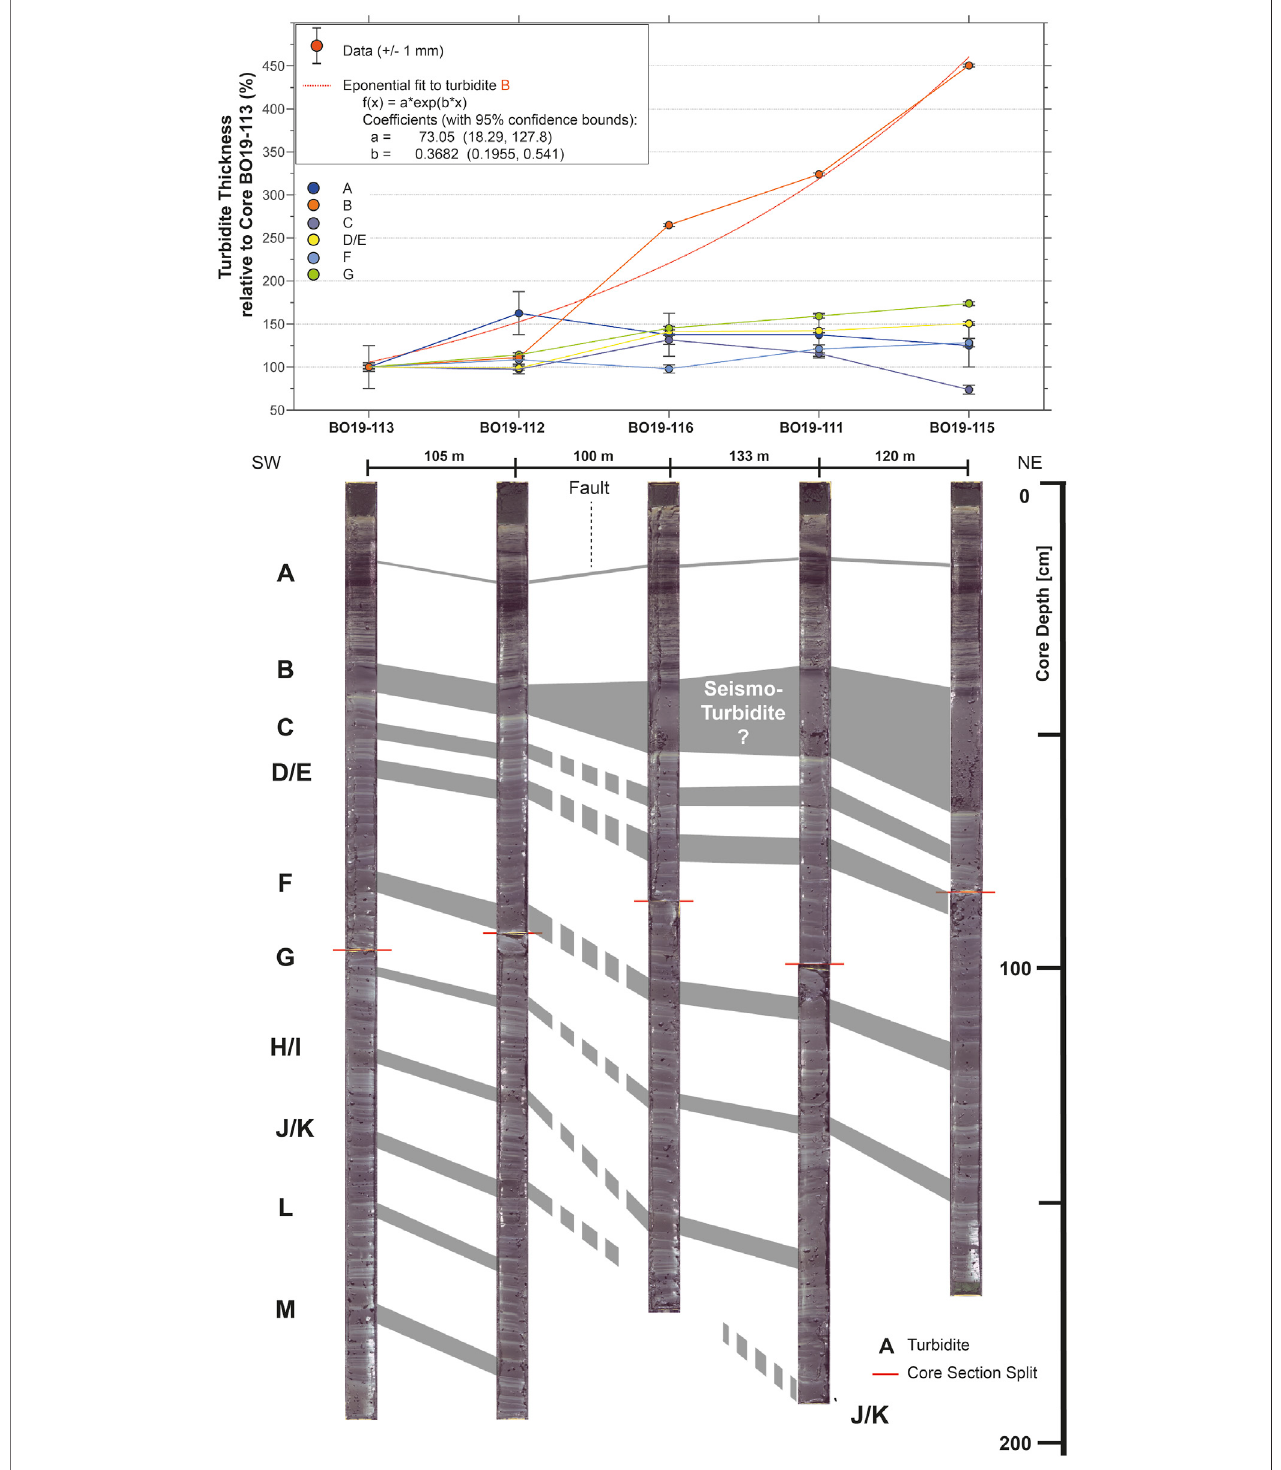
FIGURE13| Collection ofshortcoretransectacrossfaultplaneFID6(see Figure12 , SupplementaryTableS7 forlocationand details).Thicknessdevelopment ofidenti fi edturbiditesAtoMisplottedabove.Errorbarisbasedonathicknessreadingerrorof ± 1 mm,expressedaspercentageoftotalturbiditethickness.TurbiditeB expresses an exponential thickness development across the fault possibly indicative for fault activity. Other turbidites show linear thickness increase across the fault.